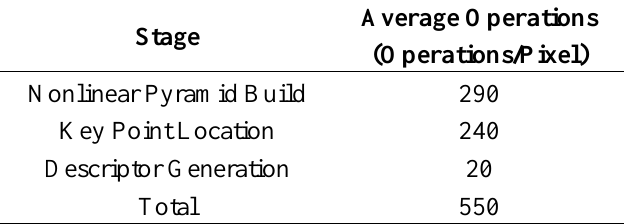
Table 5. Operations in each